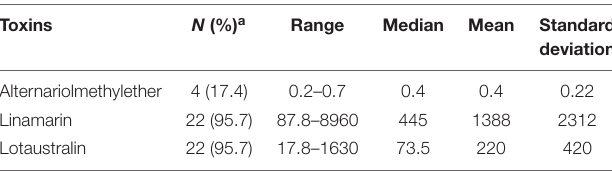
a Number (percentage) of contaminated